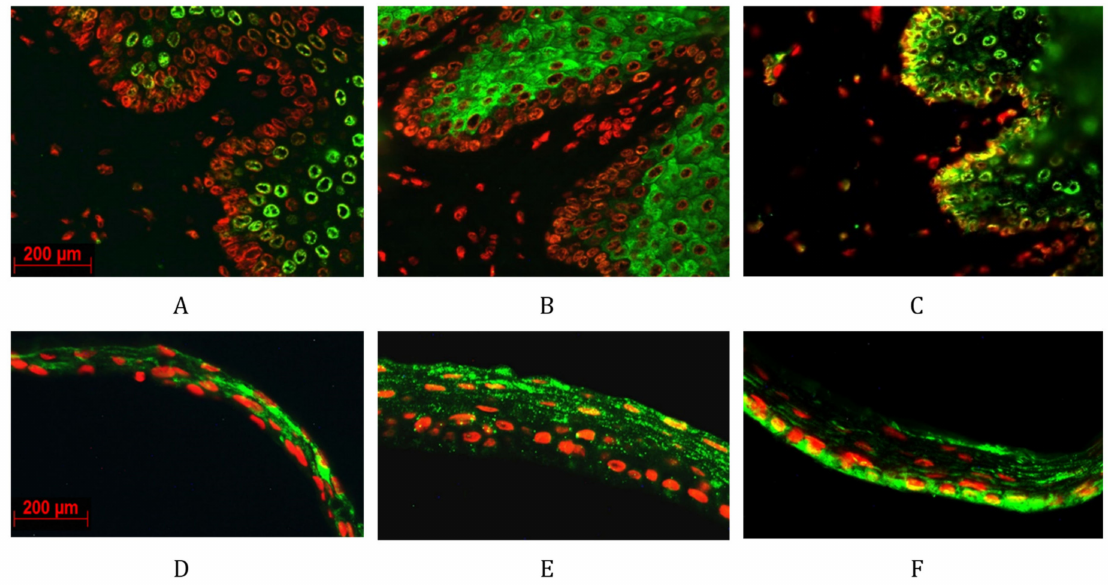
Figure 6. Immunofluorescent staining showed the expression pattern of ALDH1A1, ALDH1A3 and Pax-6 in New Zealand white rabbit oral mucosal (respectively A – C ) and in rabbit CAOMECS (respectively D – F ). ALDH enzymes and Pax-6 expression is detected in green, and nuclei are detected in red. The included images are representation of a large sample size. Magnification is 40 × . The scal barr is 200um for all the